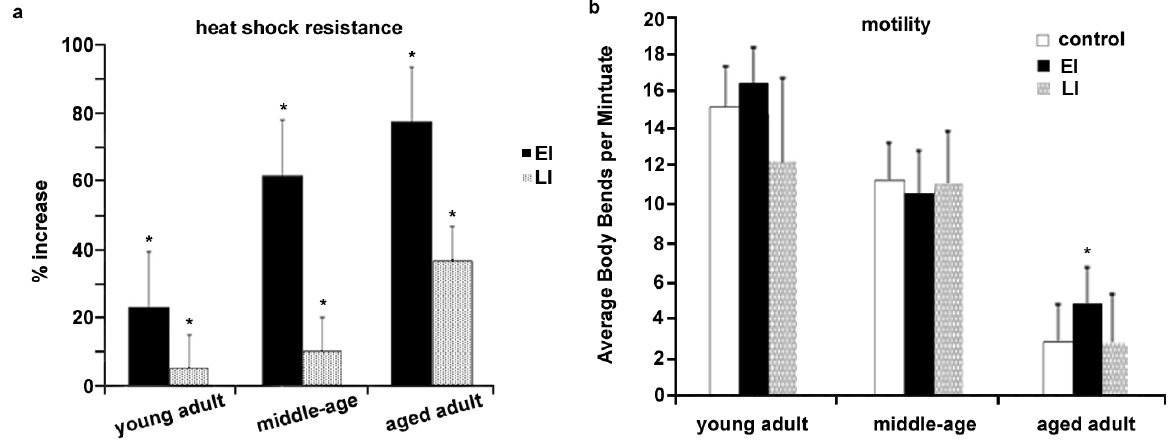
Figure 3. Outcomes of the early-start intervention and the late-start intervention on C. elegans heat shock resistance and motility. ( a ) N2 worms after either the early-start intervention or the late started intervention exhibited increased survival after 1.5 h at 37 °C when compared to control worms; ( b ) only worms after the early-start intervention showed an elevated motility rate in aged population, as compared to control worms. At least triplicate samples were examined for each stress assay. “% increase” indicates the average increase among the multi-replicates and error bars represent the standard deviation. p value was calculated using Student ʼ s t -test. * p < 0.05 when compared to control. Each of the stress assays was repeated at least three independent times with similar results. EI represents the early-start intervention; LI represents the late-start